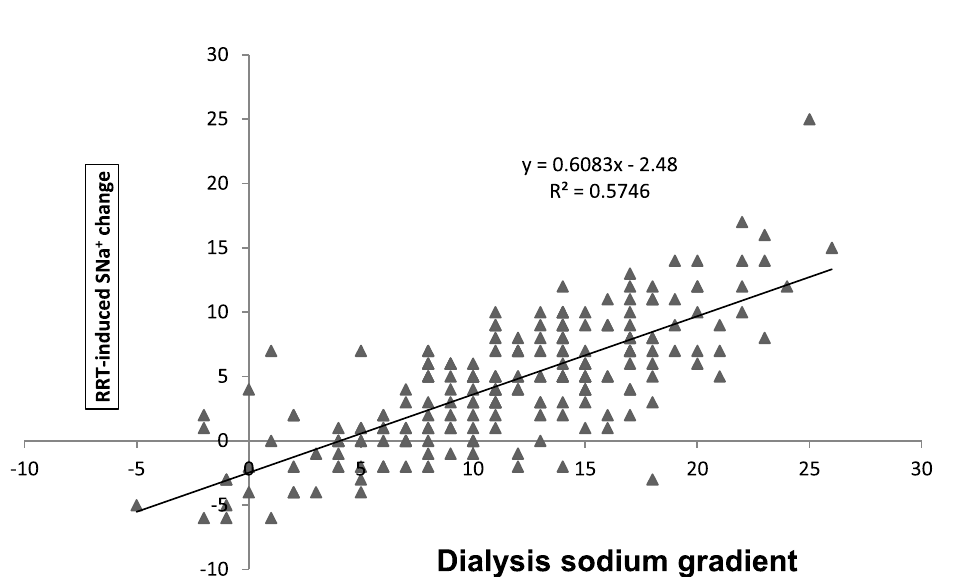
Figure 2. Correlation between the dialysate sodium gradient and the RRT-induced change in serum sodium (Pearson’s r 2 , 0.76).